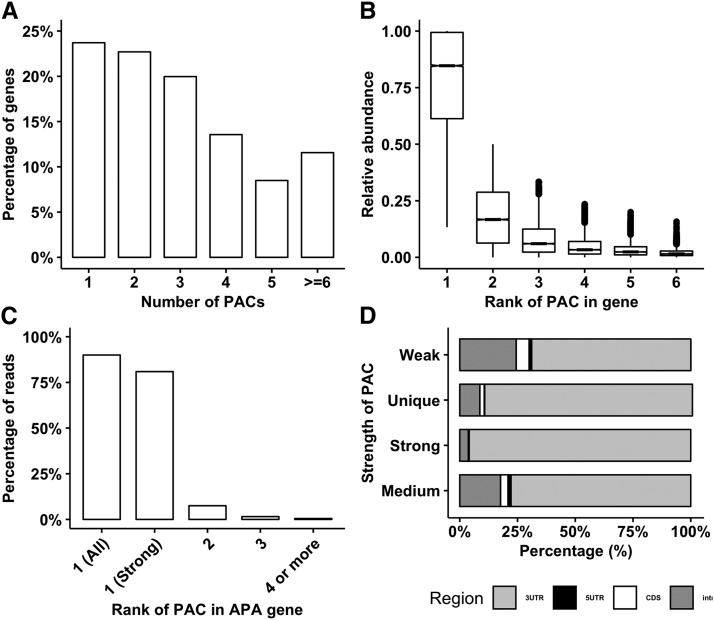
Analysis of alternative polyadenylation events. (A) Percentage of the number of PACs per gene. (B) Relative abundance of the PACs at each rank in the APA genes. For each APA gene, PACs were ranked based on the decreasing order of the relative abundances. In general, there exists one dominant PAC in APA genes. The difference between the first and second ranked PAC was statistically significant (wilcox.test p-value < 2.2 × 10−16, one-tailed greater) (C) Percentage of the total polyadenylated reads of the APA genes that were mapped to each position in the ranking. Approximately, 90% reads were mapped to the most abundant PAC. The “Strong” PACs from the 65% of the APA genes contributed the 80% of the total polyadenylated reads. (D) Majority of the non-3′UTR PACs either had a “weak” or “medium” expression levels.